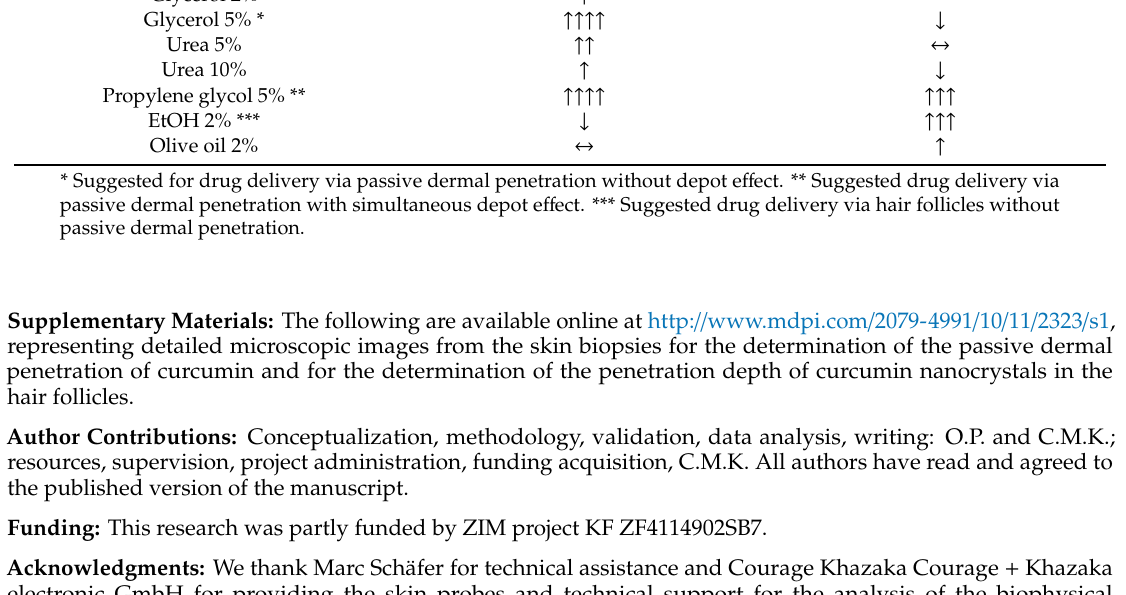
Table 3. Overview of influence of excipients on passive dermal penetration and hair follicle targeting. Type and Concentration of Excipient E ff ect on Passive Dermal Di ff usion E ff ect on Hair Follicle Targeting Glycerol 2%